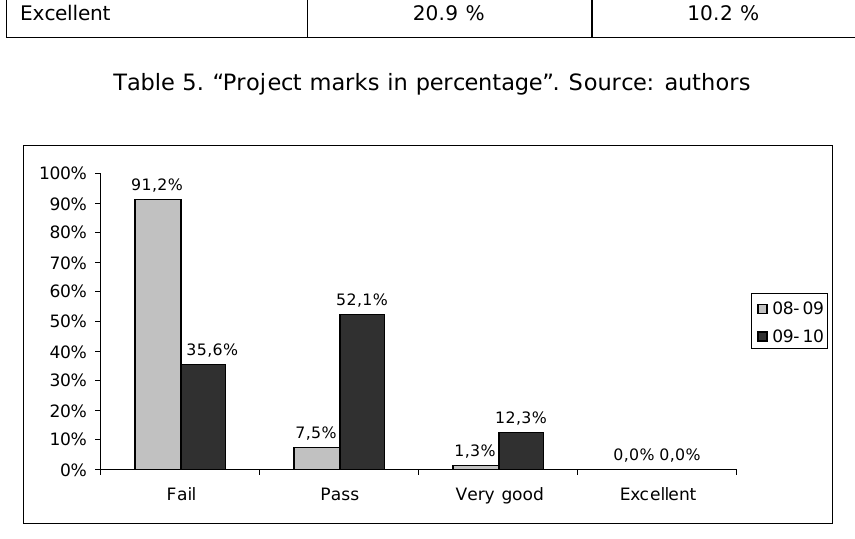
Figure 1. “Comparison of the GLOBAL results of the final theory exam of BLOCK II for academic years 08-09 and 09-10”. Source: